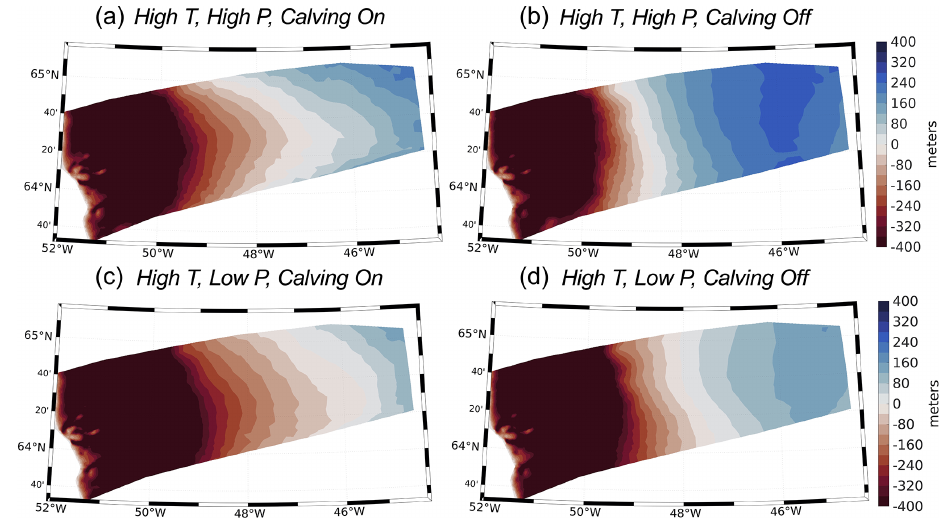
Figure 9. Simulated elevation changes (in m) during the period 12–10ka shown for experiments using the high-temperature forcing.